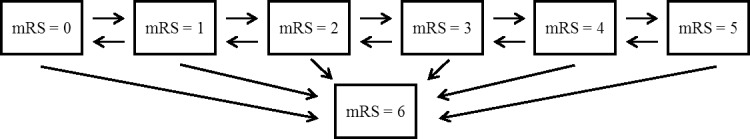
General MSMM for panel observed mRS data.